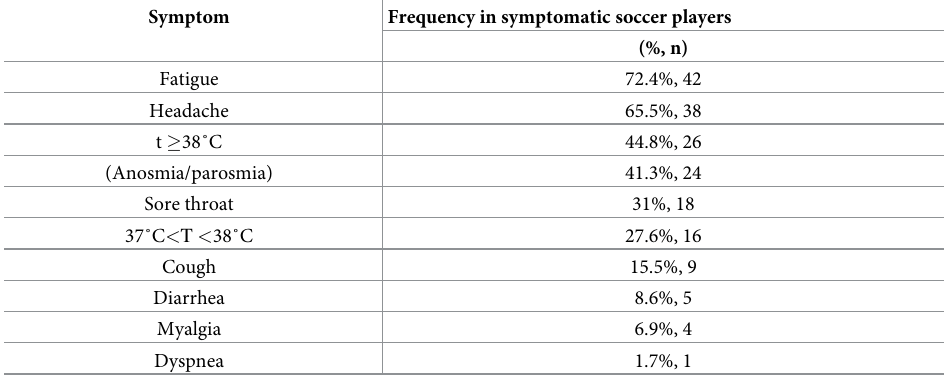
Table 1. С linical symptoms in soccer players with COVID-19